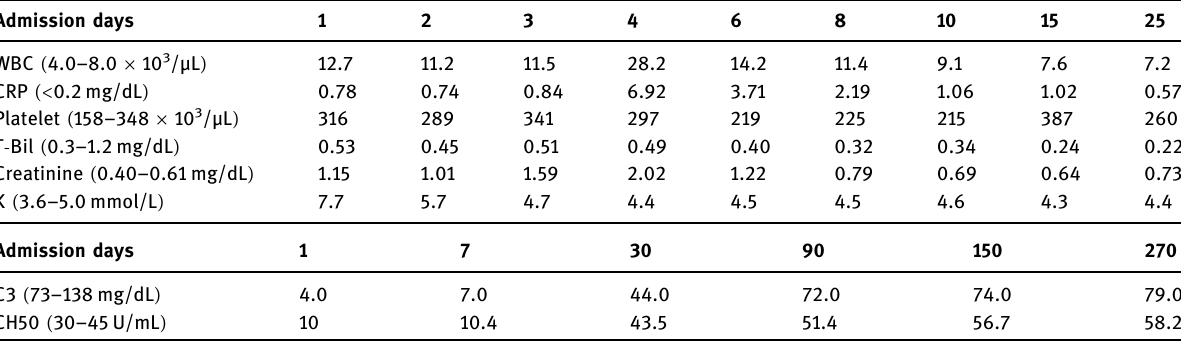
Table 3: Trends of laboratory data after admission Admission